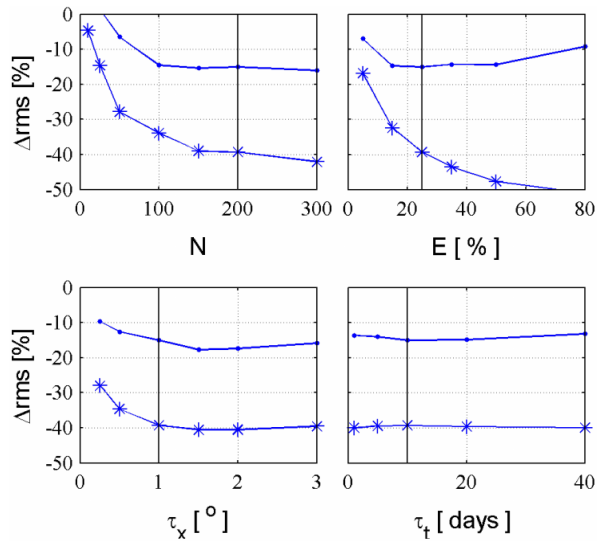
Fig. 1. Sensitivity tests of DA scheme parameters. Mean change in root-mean-square error ( 1 rms) for the assimilation (line with stars) and validation (line with dots) stream gauges as function of ensemble size ( N) , precipitation relative error ( E) and spatial ( τ x ) and temporal ( τ t ) decorrelation lengths of precipitation errors. First guess values are represented by the black